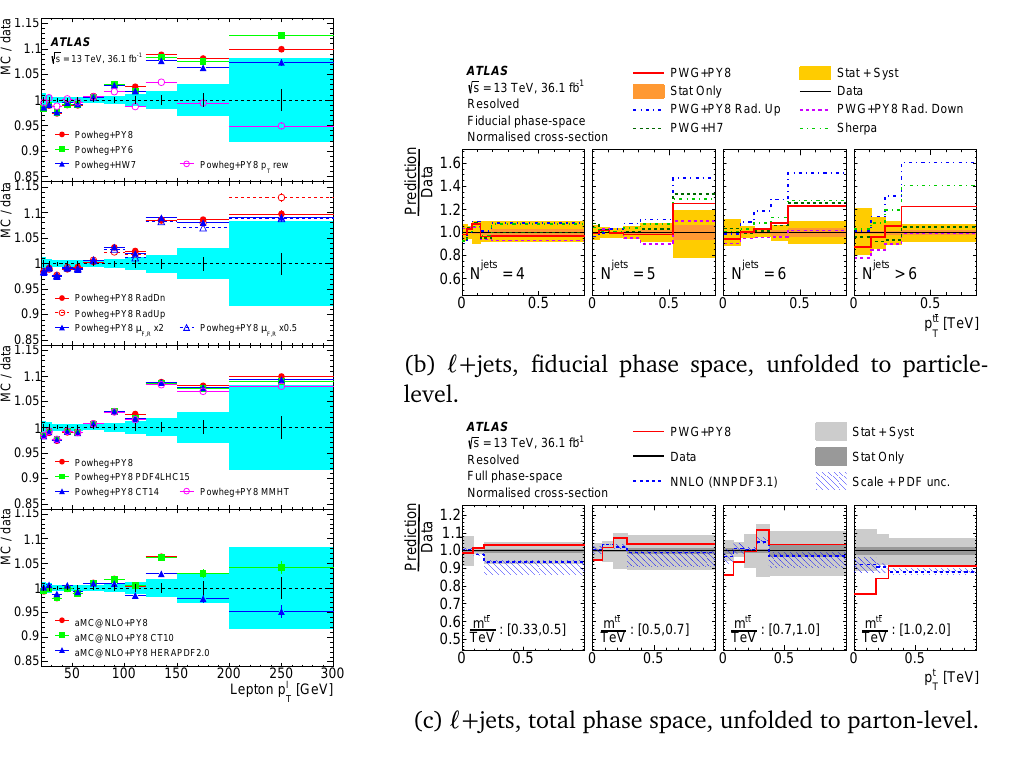
Figure 1: Ratios of predictions of normalised differential cross-sections to data as a function of kinematic variables. a: di-lepton channel [ 2 ] , cross-section as a function of the lepton p ⊥ , compared to particle-level prediction. b (c): (cid:96) + jets channel [ 3 ] , cross-section in the fiducial (total) phase space, as a function of the p ⊥ of the tt pair (top-quark p ⊥ ) in bins of the number of jets (tt invariant